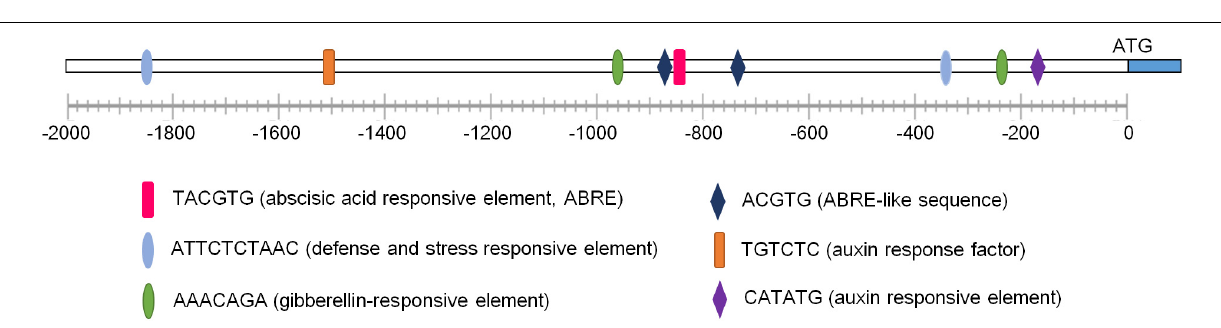
respectively ( Figure 1 and Supplementary Figure S1). The result